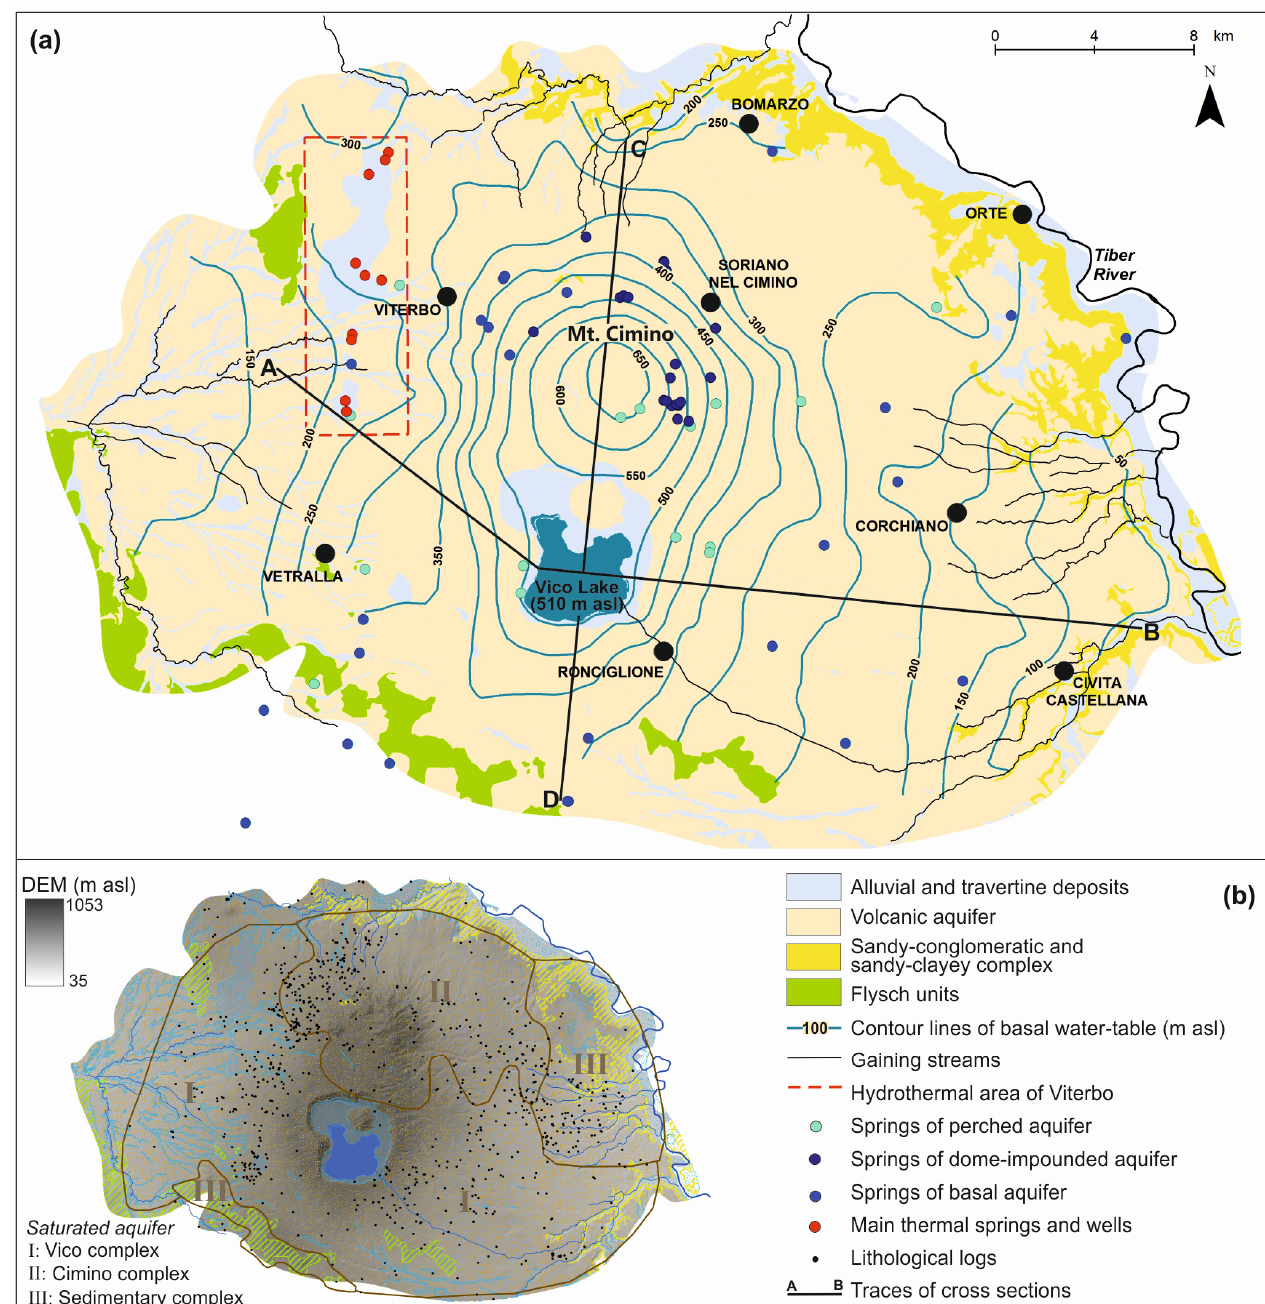
Figure 2. ( a ) Simplified hydrogeological map of the Cimino-Vico volcanic area (modified from [34]); ( b ) Map of the saturated aquifer reconstructed through the intersection of the water table with stratigraphic